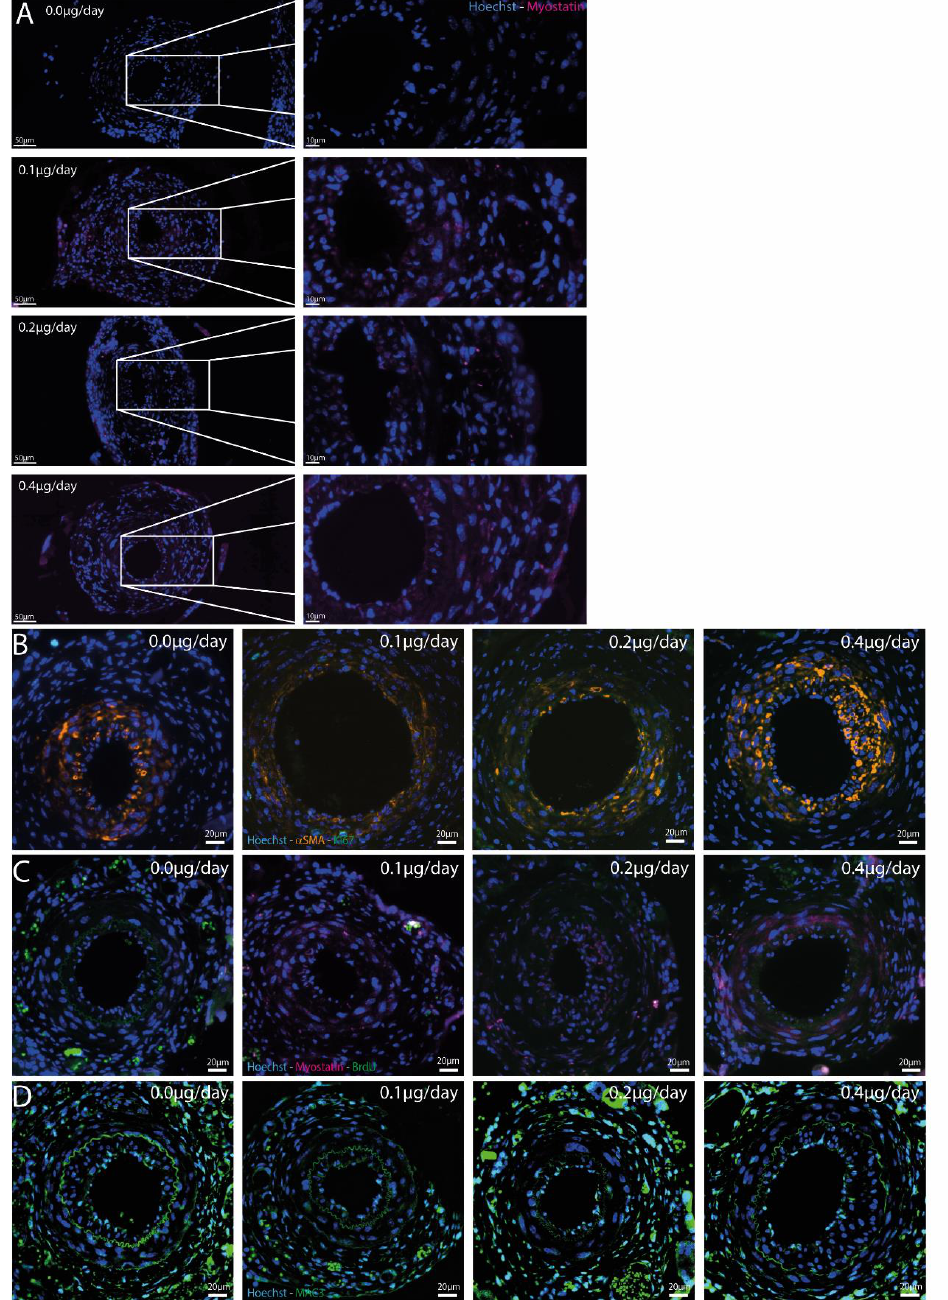
Figure 5. ( A – D ): Immunofluorescent stainings in different treatment groups. ( A )—Myostatin-Hoechst immunofluorescent double staining. Representative mouse of every treatment group is shown and zoom-in of femoral artery shows presence of myostatin in all treated groups, but not in the control group. ( B )—Ki-67- α SMA-Hoechstimmunofluorescenttriplestainingincuffedfemoralarteriesofdifferenttreatment groups shows few proliferating cells, especially not in the α SMA area. ( C )—BrdU-Myostatin-Hoechst immunofluorescent triple staining in cuffed femoral arteries of different treatment groups shows again little proliferating cells and those cells are not double stained with myostatin. ( D )—Hoechst-MAC3 immunofluorescent double staining of cuffed femoral arteries showed macrophages in all groups in both the intimal and medial layers, but no differences were